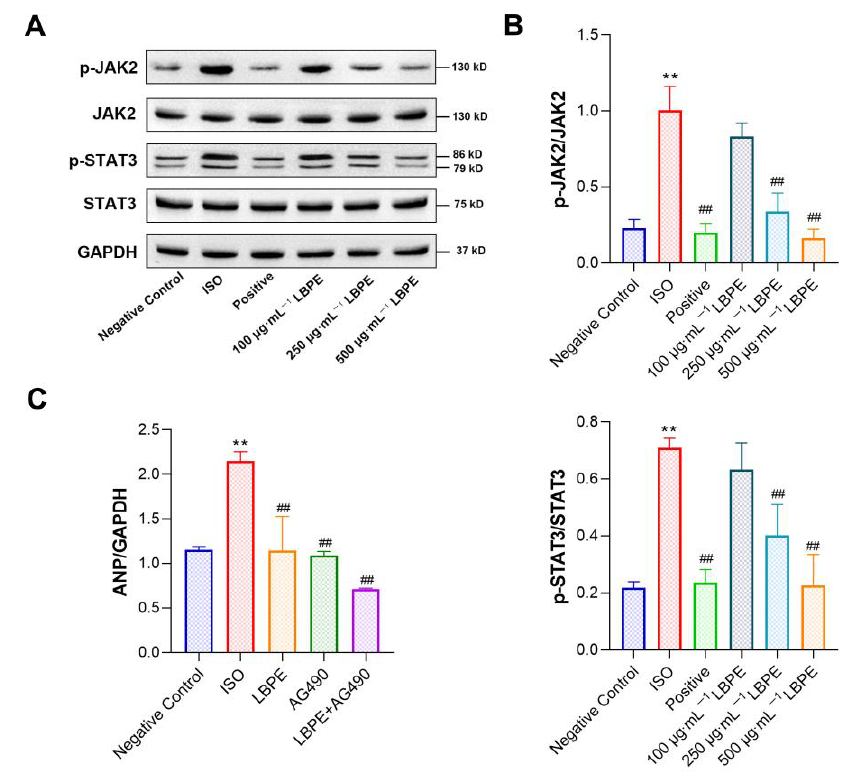
Figure 7. Effects of LBPE on JAK2/STAT3 signaling pathway in H9c2 cardiomyocytes (n = 3). ( A ) Protein expression was measured using Western blot. ( B ) Quantified Western blot results of JAK2, p-JAK2, STAT3 and p-STAT3. (C) Gene expression of ANP when treated with LBPE ( 500 μg∙mL −1 ) and/or AG490 ( 10 μmol∙L −1 ). ISO group vs. negative control group, ** p < 0.01. Positive and LBPE groups vs. ISO group, ## p < 0.01.